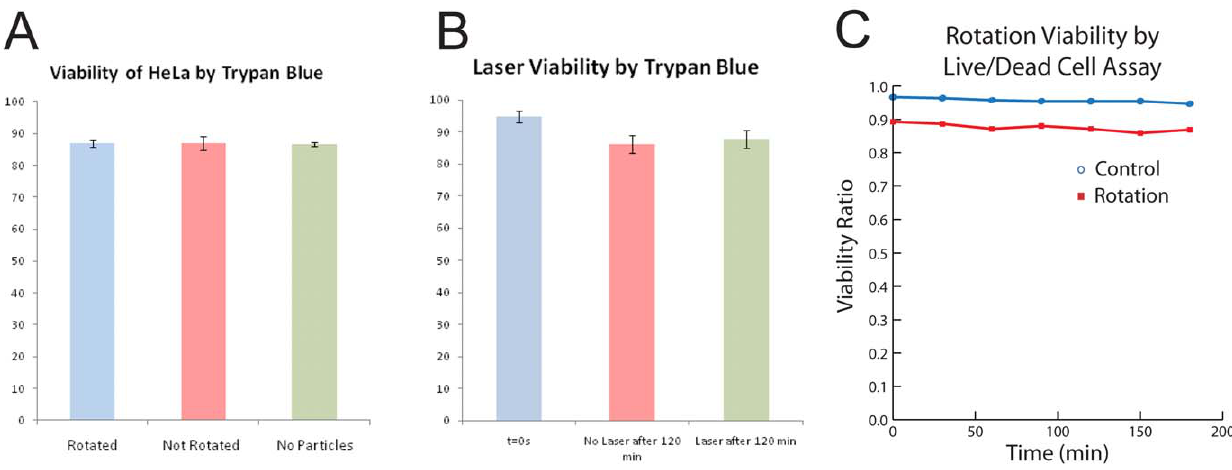
Figure 5. Magneto-rotation is harmless to the cells. a ) HeLa cells viability after incubation with nanoparticles and rotation under a rotating magnetic field. All the cells came from the same cell line, and were cultured at the same time, each for 4 days. HeLa cells were grown until reaching 70% confluency, and the first sample constituted the control group (RHS). The two other groups, incubated with magnetic nanoparticles, originated from the same cell batch, cells grown in the presence of 40 ug/ml in DMEM, until reaching 70% confluency. Each group was made of two samples containing 50,000 cells each. While the second sample was not rotated, the third one (control) was put under a field of 0.5 mT and rotated at a driving frequency of 100 Hz (LHS). During the experiment, cells were maintained at 37 u C, with 5% CO 2 and humidity control. For every group, n=3. Values represent mean + / 2 s.d. b ) Magnetic HeLa cells viability before and after laser exposure. HeLa cells were incubated with magnetic nanoparticles, for 48 hours, following the protocol described before. In a 96-well plate, 150 ul of each set of cells was pipetted. Control measurement (blue) was realized after cells were washed, detached and resuspended in fresh media at 37 u C. Non-exposed (red) and exposed cells (green) were kept on the microscope stage for 120 min at room temperature. Each well contained 25,000 cells. Values represent mean + / 2 0.5* s.d. n=3. c ) HeLa cells viability during magneto-rotation at 37 u C, with humidity and 5% CO2 control. HeLa cells were pipetted onto a Live Cell Array (NUNC TM ). The cells trapped in the 100 um wells were counted using Calcein. For both the control and the rotated cells groups, n=4. Cell death was monitored using Propidium Iodide. Standard deviations are within the dots.